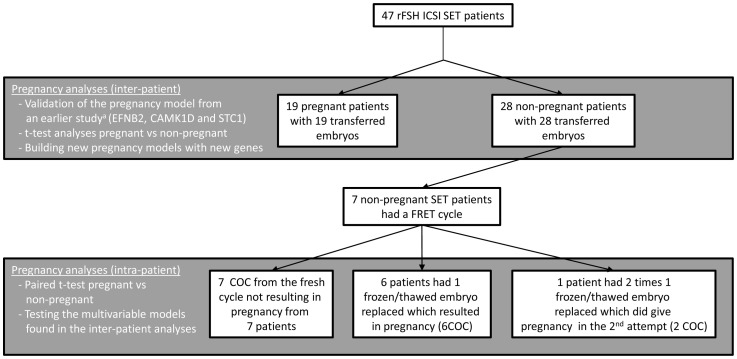
Overview of the samples used in this study.This figure represents the distribution of the samples used for the different analyses performed in this study. The grey background fields delimit the samples that were used for the specific analyses which are marked on the left side of the field. SET: single embryo transfer; FRET: frozen embryo transfer cycle; rFSH: recombinant Follicle Stimulating Hormone.a:[15].